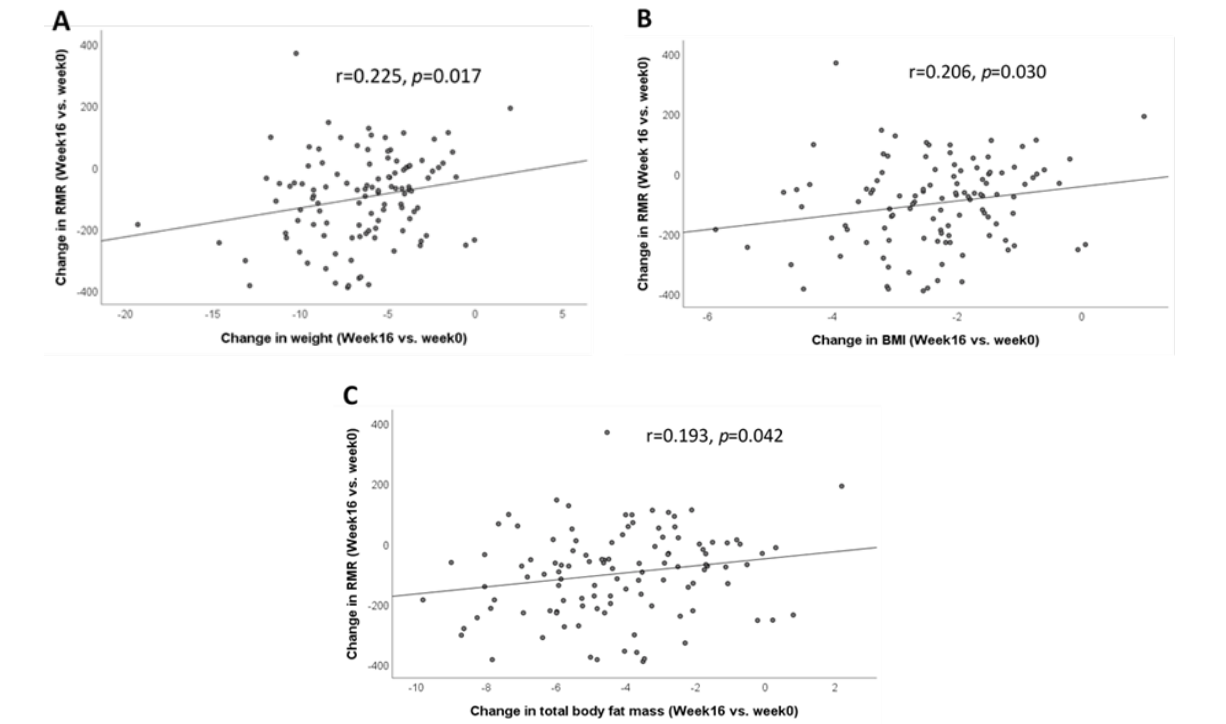
Figure 1. Correlation between change in RMR and change in anthropometric measures after 16 weeks of dietary weight loss intervention (week 16 vs. week 0). ( A ) Correlation between the change in RMR and the change in weight; ( B ) correlation between the change in RMR and the change in BMI; ( C ) correlation between the change in RMR and the change in total body fat mass. Data were analyzed by Spearman’s correlation. Abbreviations: body mass index, BMI; resting metabolic rate, RMR.